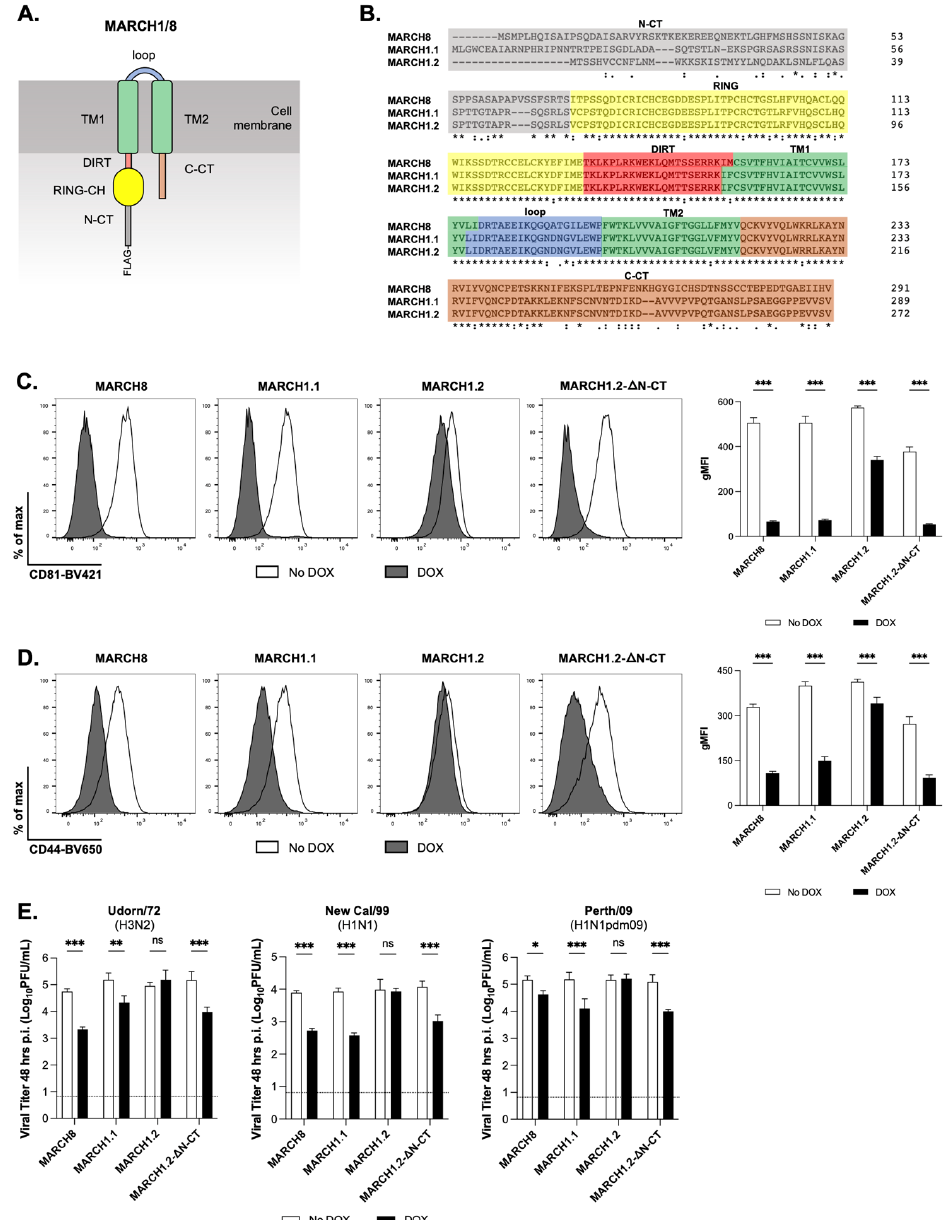
Figure 3. Differences in the N-terminal cytoplasmic domain (N-CT) between MARCH1.1 and MARCH1.2 are the key determinants of their differential ability to modulate CD44 and CD81, and to restrict IAV growth . ( A ) Schematic of the predicted topologies of MARCH1/8 highlighting domain structure and location of N-terminal FLAG tag used in our studies. ( B ) Sequence alignment of human MARCH8, MARCH1.1 and MARCH1.2. proteins using CLUSTAL OMEGA 1.2.4. In ( A , B ), N-terminal cytoplasmic tail (N-CT) is grey; RING-CH domain is yellow; the domain in between the RING-CH and the first transmembrane domain (DIRT) is red; Transmembrane domains (TM1/2) are green, the extraluminal connecting loop is blue and C-terminal cytoplasmic tail (C-CT) is brown. ( C , D ) Here, 293T cells cultured in media alone (no DOX) or supplemented with 1 mg/mL DOX (DOX) for 24 h were detached, washed and stained for cell-surface expression of CD81 ( C ), or CD44 ( D ). Representative histograms and geometric mean fluoresce intensity (gMFI ± SD) from triplicate samples are shown. ( E ) Cells cultured in media (no DOX, white bars) or DOX-induced for 24 h (DOX, black bars) were infected with Udorn/72 (H3N2), New Cal/99 (H1N1) or Perth/09 (H1N1pdm09) (MOI = 0.01), washed and then virus titres in clarified supernatants from triplicate